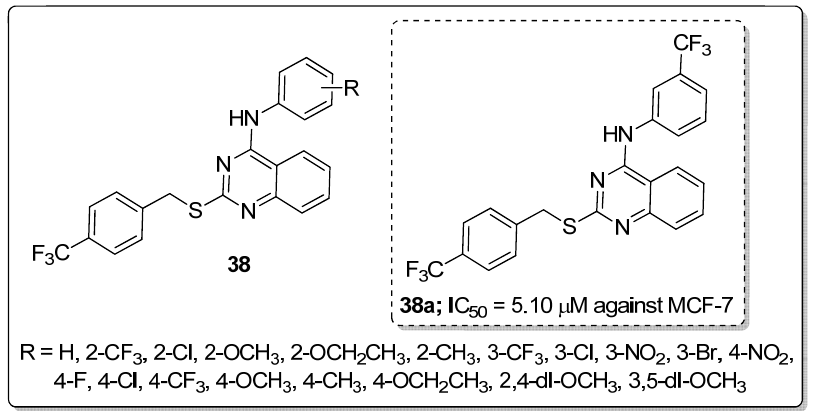
Figure 44. Antitumor activity of the most active quinazoline conjugate 38a .